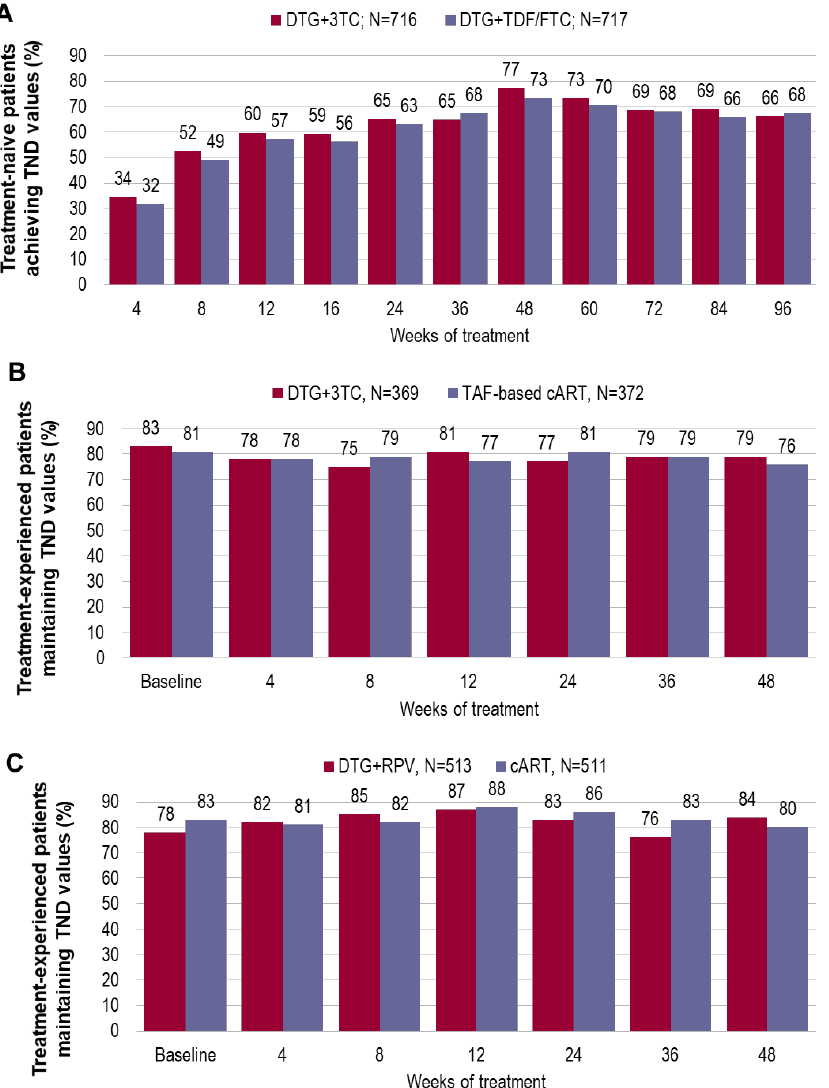
Figure 3. Achievement and maintenance of non-detectable viral-load values in patients enrolled in dolutegravir-based two-drug regimens clinical trials. Histograms represent individual studies—not a head-to-head comparison. ( a ) Proportion of drug-naïve participants with TND values by week of treatment from GEMINI-1 and -2 studies (snapshot analysis). ( b ) Proportion of treatment-experienced participants with TND values by week of treatment from the TANGO study (snapshot analysis). ( c ) Proportion of TND values by week of treatment for treatment-experienced participants with TND at baseline, from the SWORD-1 and SWORD-2 studies. 3TC = lamivudine; cART = combination antiretroviral therapy; DTG = dolutegravir; FTC = emtricitabine; RPV = rilpivirine; TAF = tenofovir alafenamide; TDF = tenofovir disoproxil fumarate; TND = Target not detected. The quantification of total HIV-DNA in peripheral blood mononuclear cells (PBMCs) represents the most widely used indicator of the HIV cellular reservoir size and dynamics [86]. Both MONI [87] and MONET trials [88] provided initial data on the possibility to maintain the control of HIV-1 DNA levels through 144-weeks by using DTG monotherapy